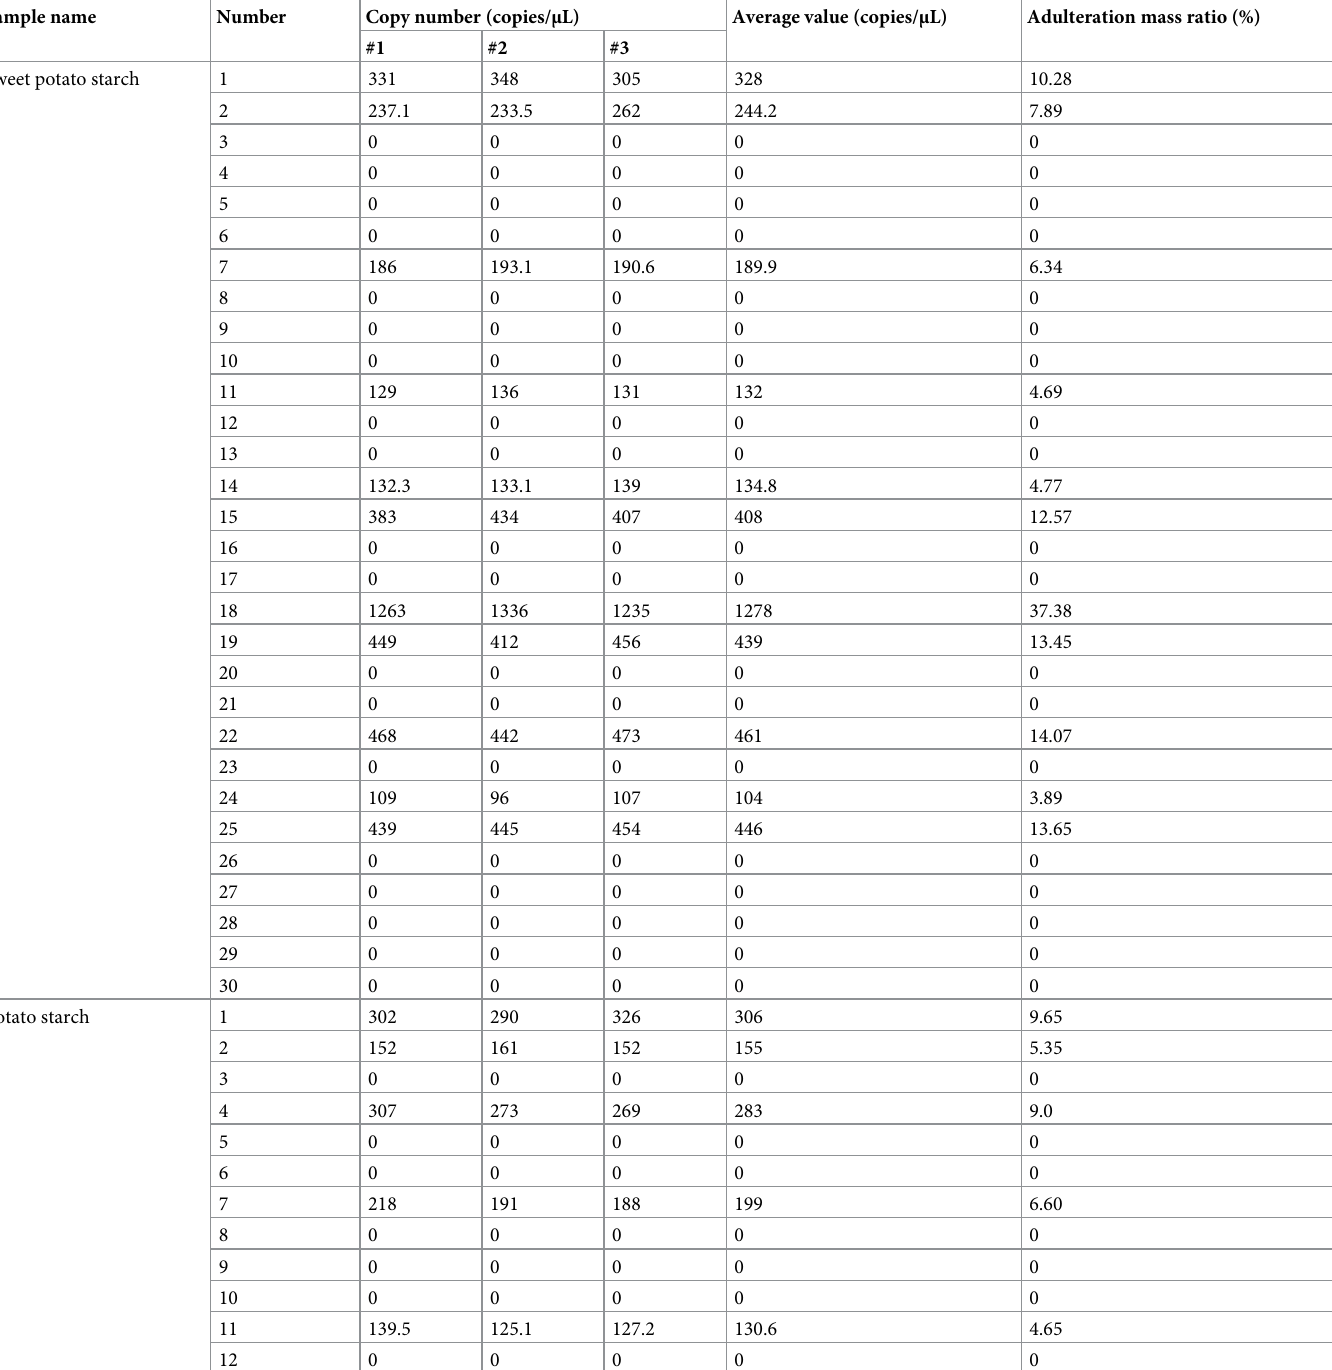
Table 7. Analysis of commercially available